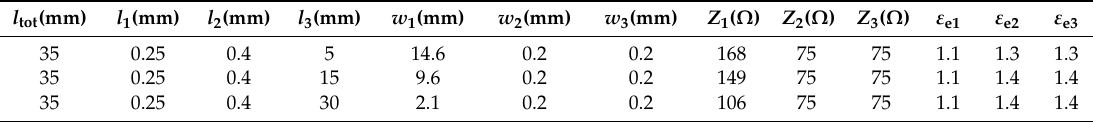
Table 1. Characteristic impedances and relative dielectric constants of the meander slot